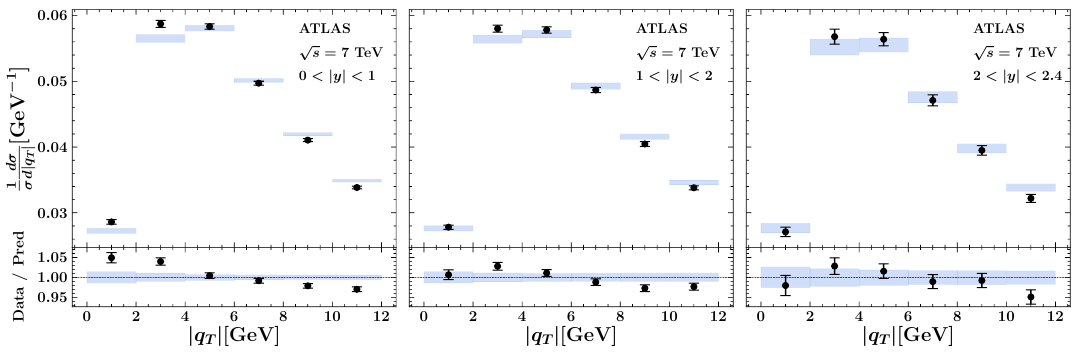
Figure 11 . Same as in the left and central panels of previous figure, but for ATLAS kinematics at √ s = 7 TeV. From left to right, results at increasing rapidity.